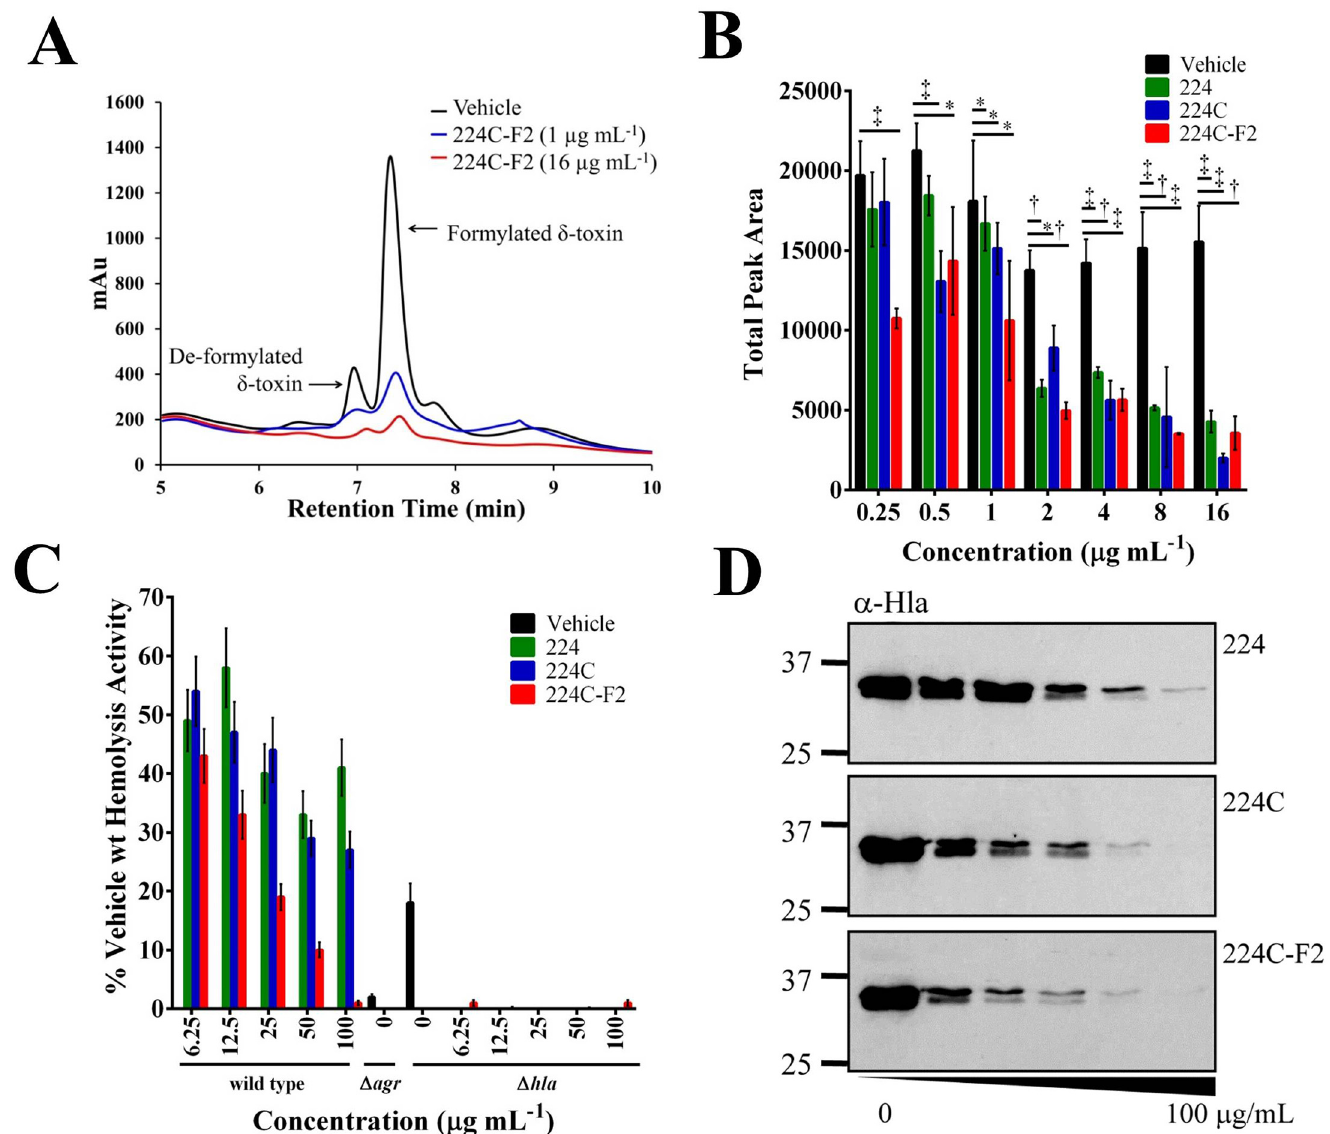
Fig 4. 224C-F2 blocks MRSA exotoxin production. (A) 224C-F2 demonstrates a dose-dependent effect in inhibition of de-formylated and formylated delta toxin, as illustrated in this HPLC chromatogram. (B) Quantification of delta-toxin confirmed the dose-dependent inhibitory activity of extracts, and the increased activity of the refined fraction 224C-F2 over 224 and 224C. (C) Extracts quench the hemolytic activity of both the S . aureus wild type and Δ hla mutant, demonstrating that in addition to preventing production of α -hemolysin (responsible for the major share of hemolytic activity), that extracts also inhibit PSM production, responsible for the observable hemolytic activity in hla mutant strains. All treated groups are significant in comparison to the vehicle control ( p < 0.001). (D) USA300 ( Δ spa ) was exposed to increasing doses of 224, 224C, 224C-F2, and vehicle control for 8 hrs. Western blot for α -hemolysin on supernatants demonstrated a dose-dependent decline in protein levels. Significant differences between treatment and vehicle are represented as: * : p < 0.05; ‡ : p < 0.01; † : p < 0.001. (224, 224C, 224C-F2), cytotoxicity ( > 30%) was only observed at doses at 8 – 10 times greater than the dose range necessary for quorum quenching activity, and which also corresponded with the rise in toxicity of vehicle treatment alone (DMSO), with no significant difference in cytotoxicity between the vehicle and extracts (Fig 7A). With regards to the potential for irritant or necrotic effects on murine skin, mice were injected intradermally with either 5 μ g or 50 μ g